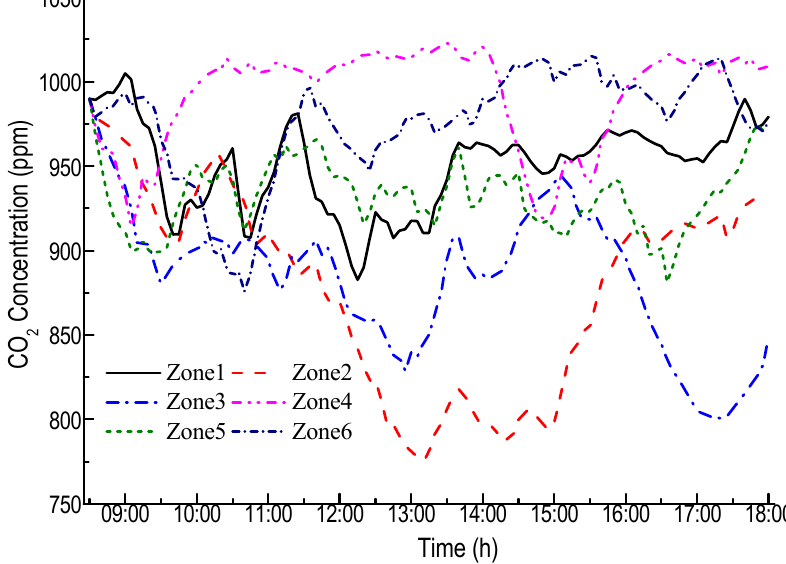
Figure 11. The CO 2 concentration of six thermal zones under Scenario 3.